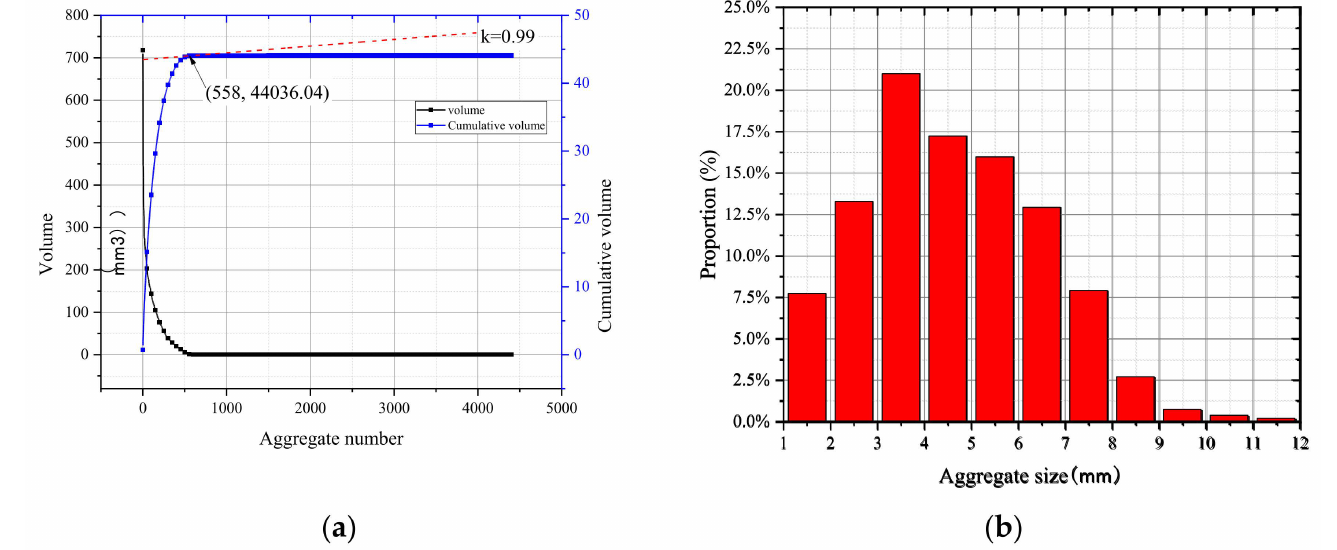
Figure 17. Statistical curves of aggregate distribution: ( a ) aggregate volume and cumulative volume distribution curves; ( b ) proportion of the aggregate